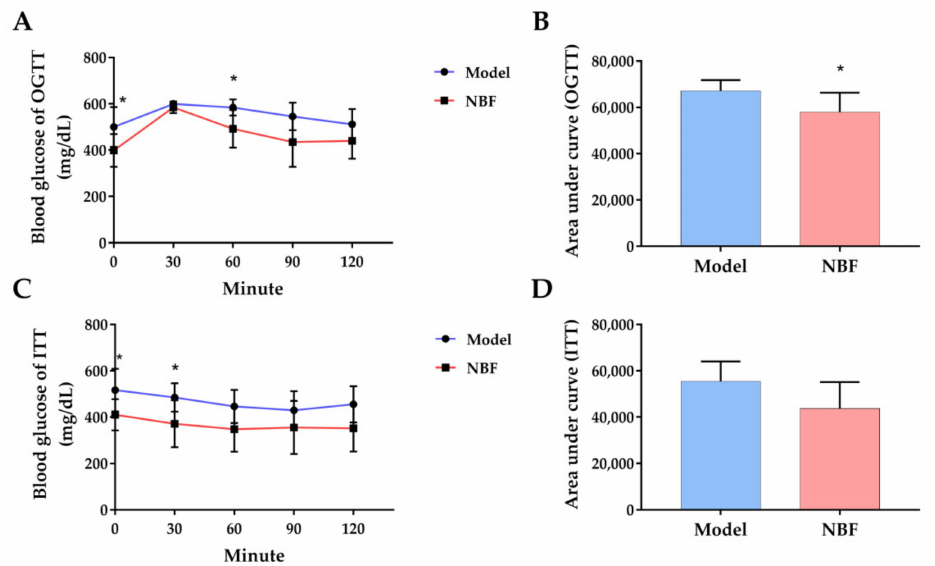
Figure 7. Effects of NBF on OGTT and ITT in db/db mice. ( A ) The changes in blood glucose level within 2 h after glucose load, ( B ) the area under the curve of OGTT, ( C ) the changes in blood glucose level within 2 h after insulin injection, and ( D ) the area under the curve of ITT. Model: diabetic mice untreated; NBF: diabetic mice treated with NBF at a dose of 200 mg/kg body weight. Data are presented as mean ± SD ( n = 6); * p < 0.05 versus model group.